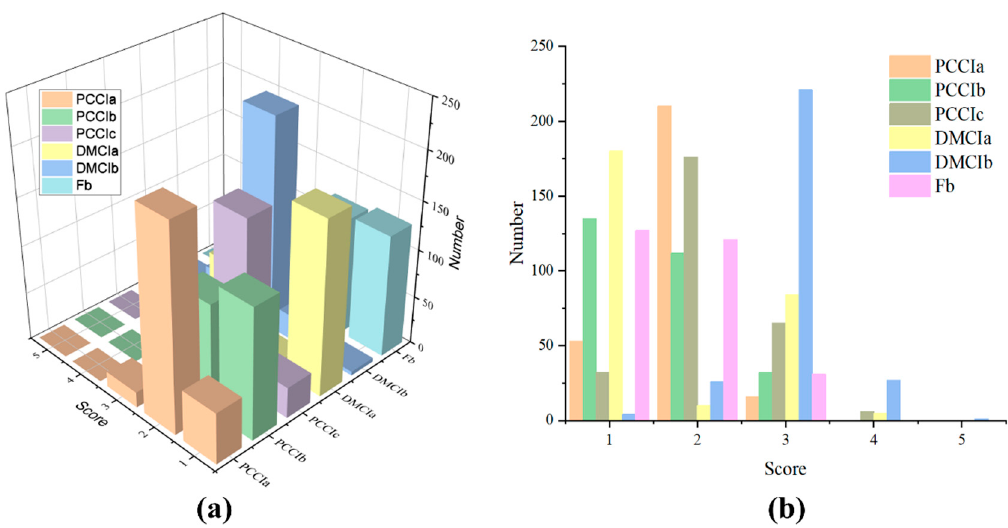
Figure 6. Distribution of technical status of bridge components: ( a ) Overall distribution of bridge component status grades; ( b ) Number of bridges in different state levels.